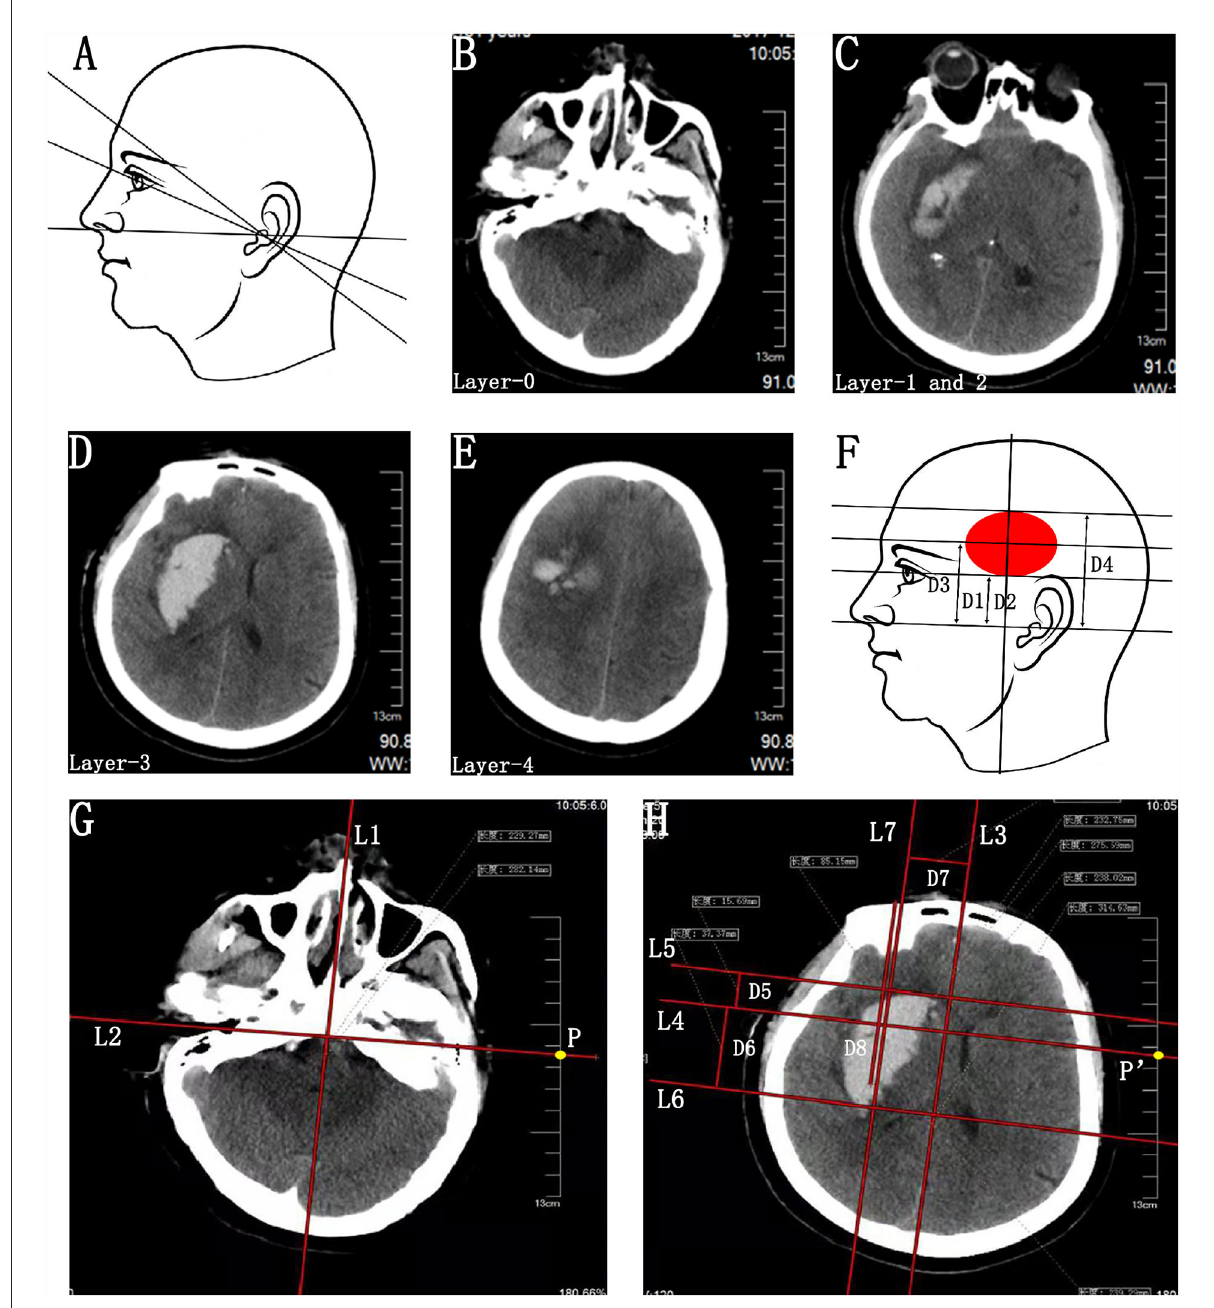
FIGURE1 Preoperative parameter acquisition of BGH on the basis of individualized CT scan images. (A) Schematic diagram of various baseline planes of CT scan. (B–E) CT scan image passing through the external auditory canal (Layer-0) (B) , eye’s lenses (Layer-1) (C) , bottommost (Layer-2) (C) , largest (Layer-3) (D) , and uppermost (Layer-4) (E) layers of BGH. Layer-1 and Layer-2 exactly coincided in this case. (F) Schematic diagram of hatch spacing distance between Layer-0 and Layer-1 (D1), Layer-2 (D2), Layer-3 (D3), and Layer-4 (D4). D1 and D2 were the same in this case. (G) On Layer-0, a midsagittal line (L1) and its perpendicular line (L2) passing through the bilateral external auditory canal were drawn, making sure that the L2 was long enough to intersect with the CT scale at point P. The point P was defined as the sagittal projection point of the external auditory canal. (H) On Layer-3, a midsagittal line (L3) and its perpendicular line (L4) passing through the point P ′ were drawn according to the same method as above, making sure that points P and P ′ were at the same position on the CT scale. The point P ′ was defined as the sagittal projection point of the external auditory canal on this CT scan layer and L4 was identified as the reference line of the bilateral external auditory canal based on the actual CT baseline plane. Two parallel lines (L5 and L6) of the L4 were drawn passing through the anterior and posterior border of hematoma, respectively. Then, the distance between the parallel lines (L5-L4 and L6-L4) was measured and defined as D5 and D6. A line (L7) parallel to the L3 was drawn passing through the center of BGH. The distance between L3 and L7 was D7. The D7 was recognized as the distance of the planned puncture point lateral to the L3. Due to morphological heterogeneity of hematoma, the planned penetration depth (D8) of the catheter was defined as the distance along the line L7 from the head surface to the midpoint or anterior 2/3 point of the hematoma. BGH, basal ganglia